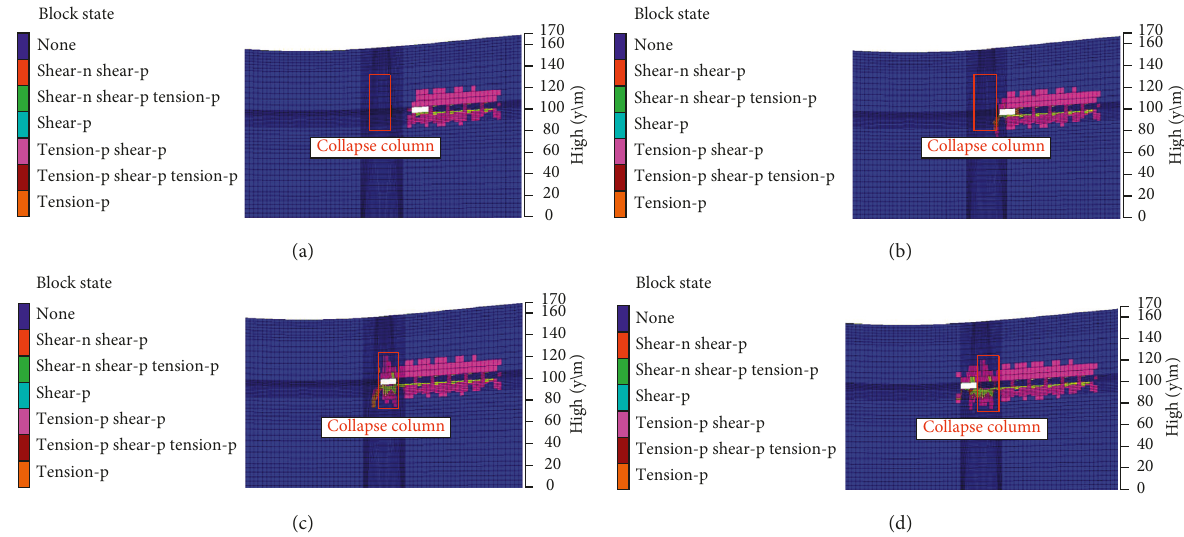
Figure 5: Plastic zone of surrounding rocks in the working face process: (a) working face 25m ahead of the collapse column, (b) working face 5m ahead of the collapse column, (c) working face above the collapse column, and (d) working face 10 m behind the collapse column.